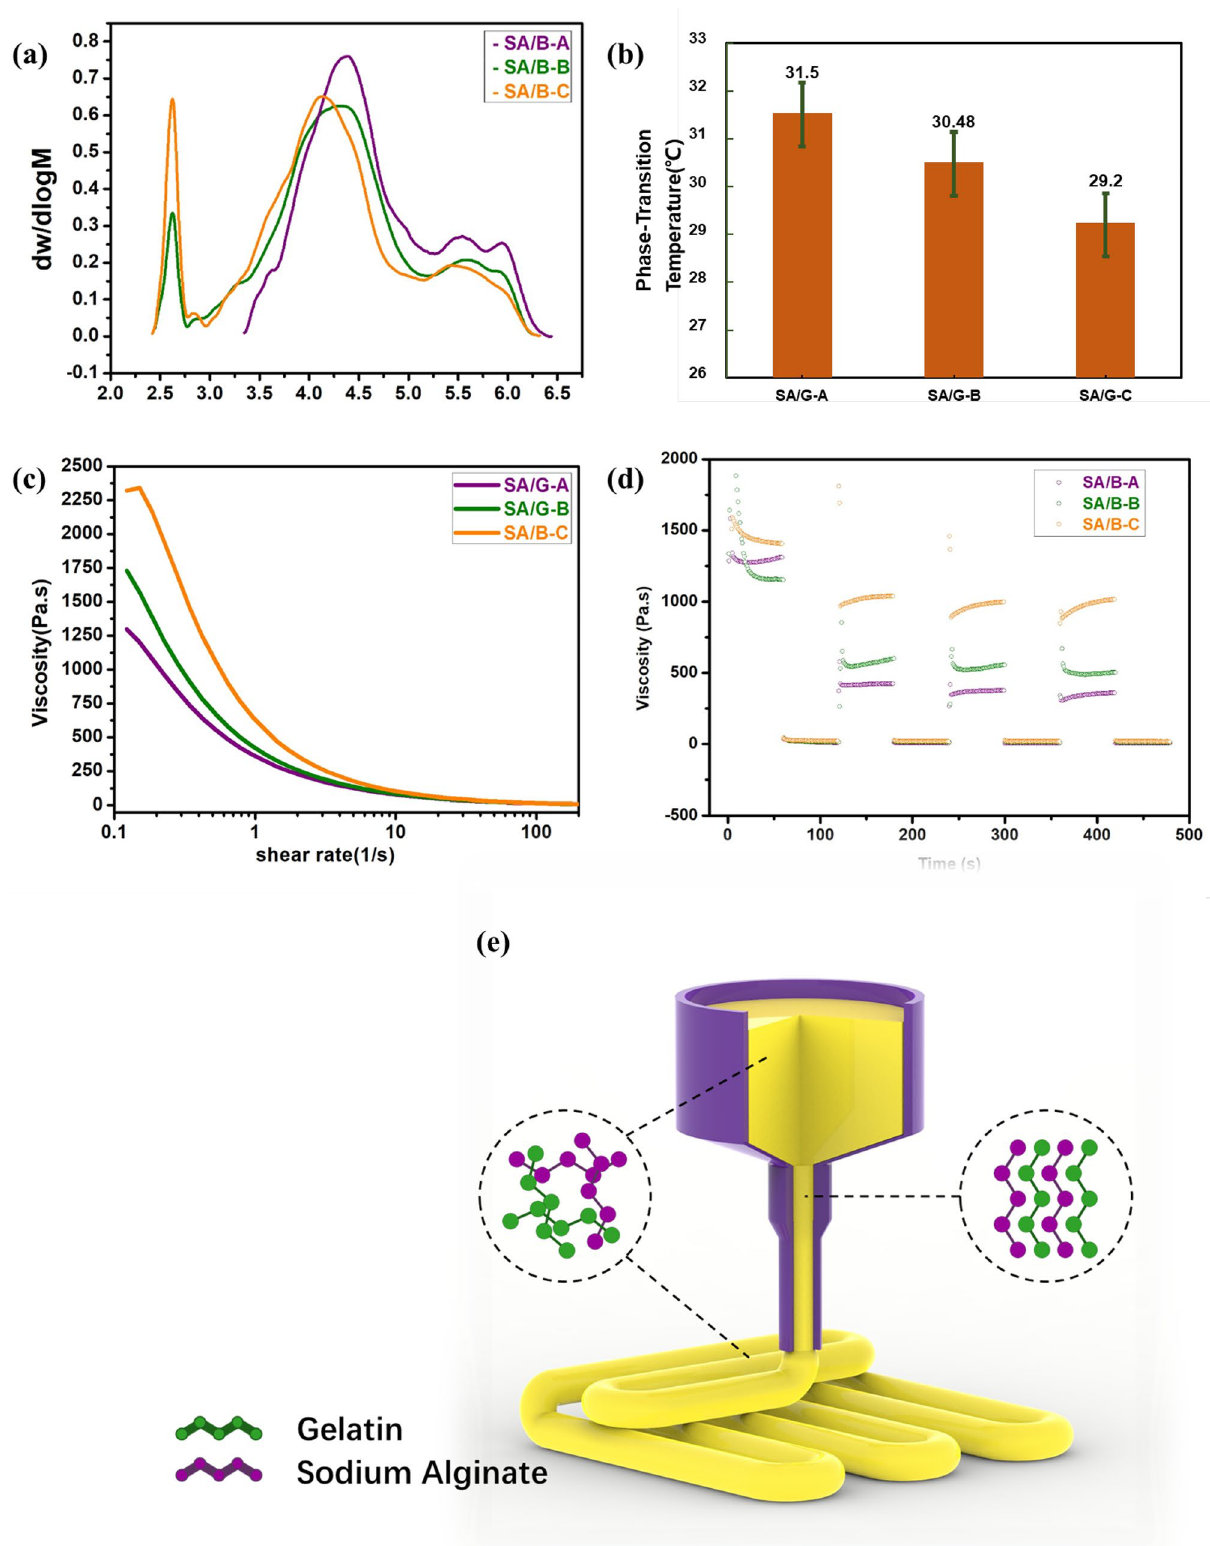
Figure 3. Molecular weight and rheological characterization of bio-inks. ( a ) The molecular weight distribution of SA/G-A, SA/G-B, and SA/G-C; ( b ) Phase transition temperature of gel-sol; ( c ) Viscosity-shear rate diagram; ( d ) The thixotropy of bio-inks and ( e ) Schematic diagram of shear-thinning